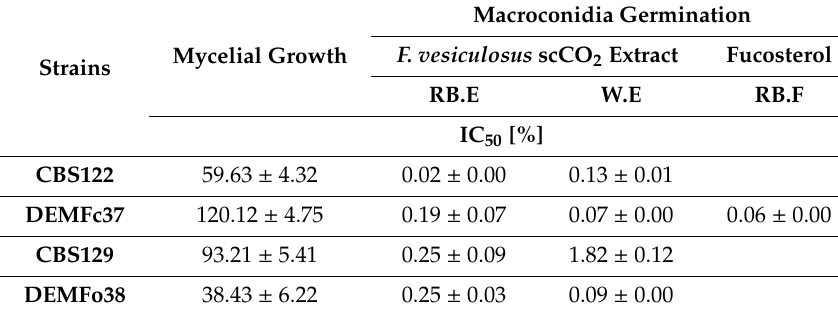
Table 2. The IC 50 of Fucus vesiculosus scCO 2 extract and